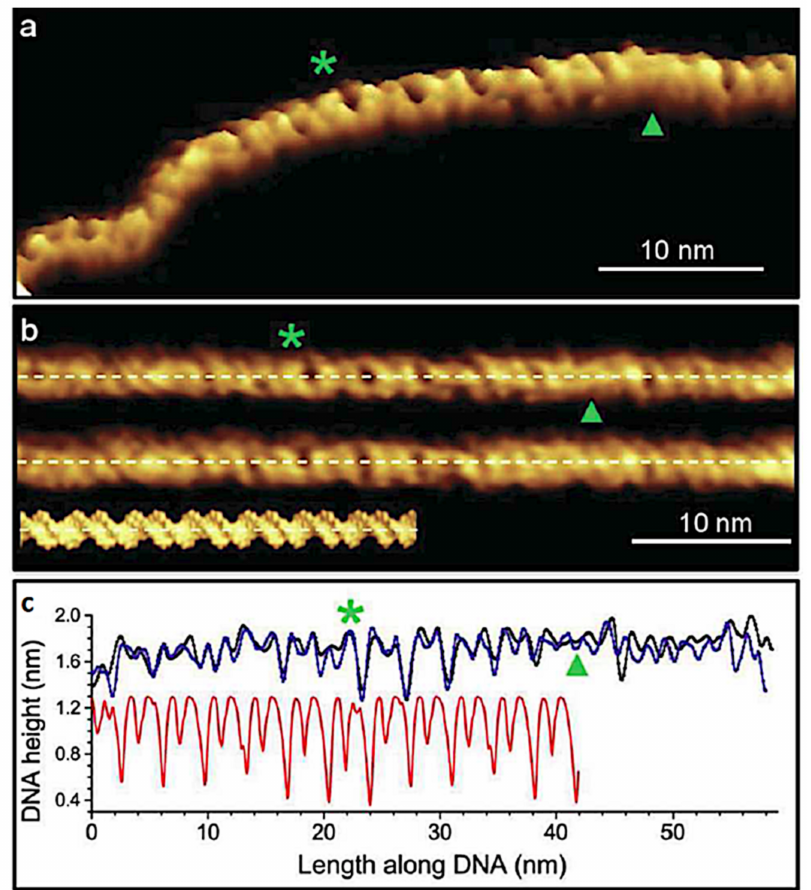
Figure 4. The analysis of Peak-Force Tapping mode AFM image of the B-DNA plasmid segment. The po- sitions of the major and minor grooves are marked by green asterisks and triangles respectively. The color scale representing the height is saturated and extending up to at 1.1 nm. The digitally